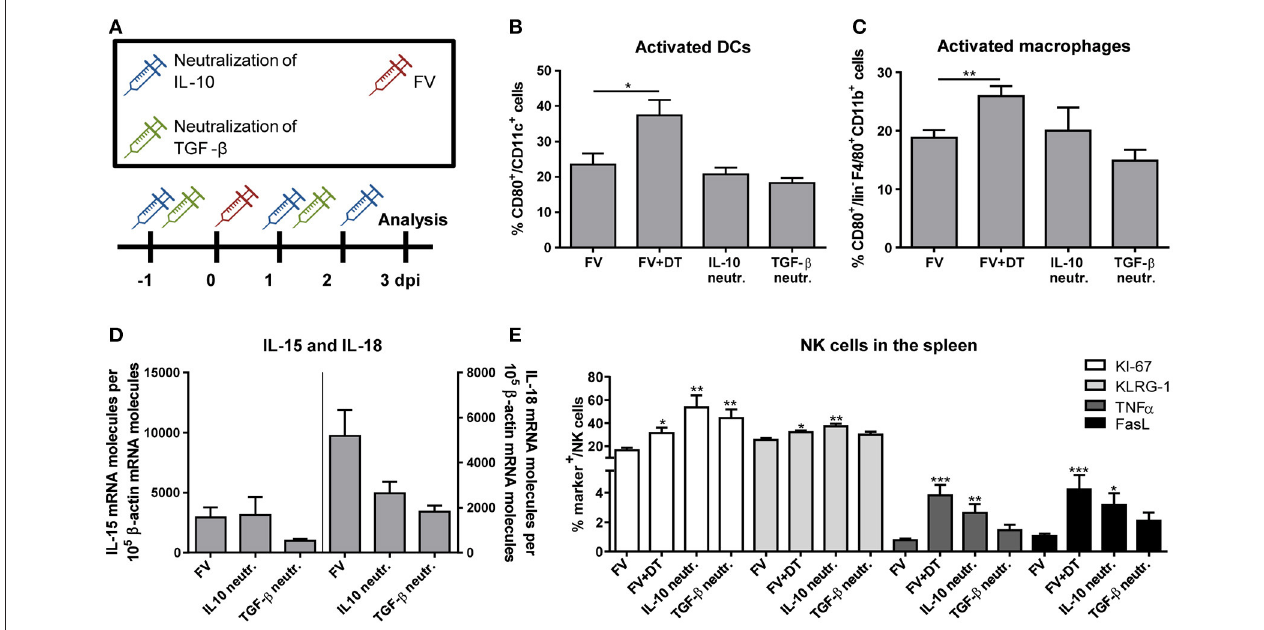
FIGURE 5 | Influence of IL-10 and TGF- β neutralization on innate immune cells during an acute FV infection. Mice were infected with FV and groups of infected mice were also neutralized for IL-10 (IL-10 neutr.) or TGF- β (TGF- β neutr.) as displayed in (A) . Spleens of FV-infected mice were removed at 3 dpi and single cell suspensions were prepared. Activation of DCs (B) and macrophages (C) were analyzed by flow cytometry ( B,C : IL-10 neutr. n = 7; TGF- β neutr. n = 6). mRNA expression levels of IL-15 (left; IL-10 neutr. n = 13; TGF- β neutr. n = 12) and IL-18 (right; IL-10 neutr. n = 14; TGF- β neutr. n = 12) were analyzed in spleen cells of FV-infected (FV) and IL-10- or TGF- β -neutralized mice by quantitative real-time PCR (D) . The housekeeping gene β -actin was amplified for each sample as an internal standard and for normalization. Samples were collected from two independent experiments and were run in duplicate. One outlier was removed using the Rout method. In E, the effector phenotype of NK cells was determined by the expression of KI-67 (white bars, n = 7), KLRG-1 (light gray bars), TNF α (gray bars) and FasL (black bars). At least 6 animals were used from at least two independent experiments (IL-10 neutr. n = 7; TGF- β neutr. n = 6). Statistically significant differences were analyzed by ordinary one-way ANOVA (B,C) or Kruskal–Wallis (E) test and are indicated as follows: * p < 0.05, ** p < 0.01, *** p < 0.001. Percentages are shown as mean ±